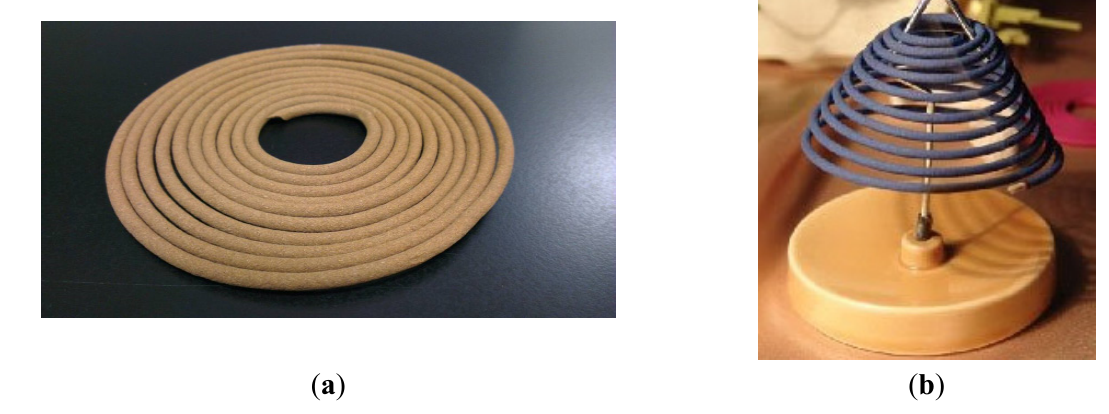
Figure 1. Incense coil. ( a ) Original incense coil. ( b ) Spread and burned incense